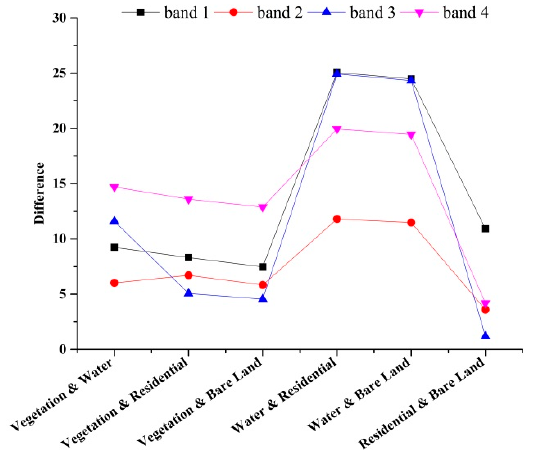
Figure 9. Comparison of differences in the mean grey value of each band for vegetation and residential land.